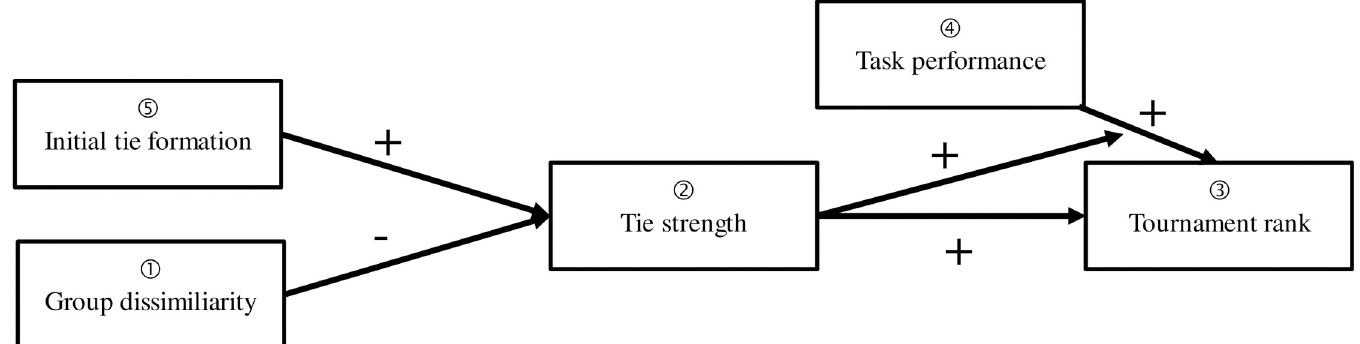
Fig 1. The role of social networks in